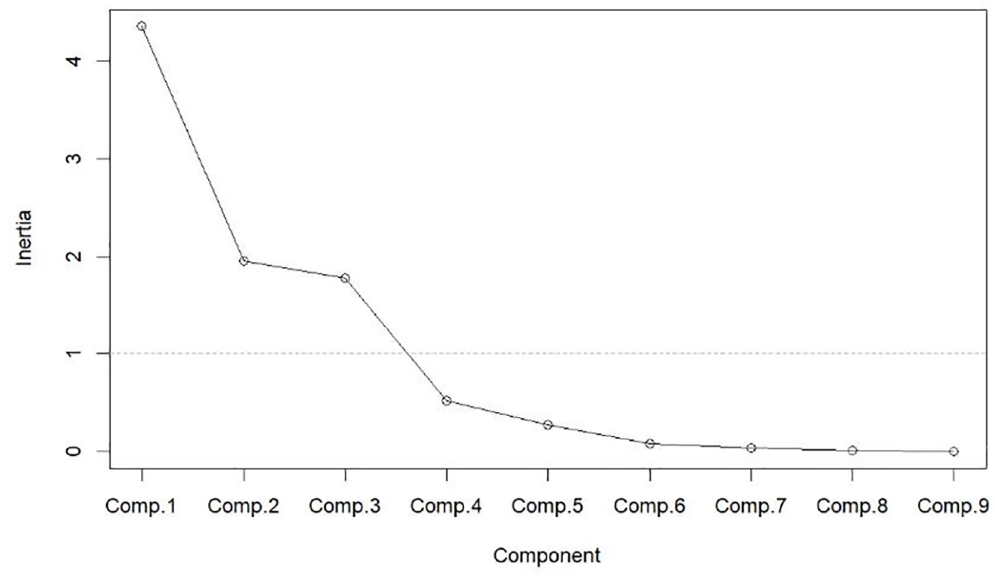
Fig 6. Gravel map of principal component analysis.